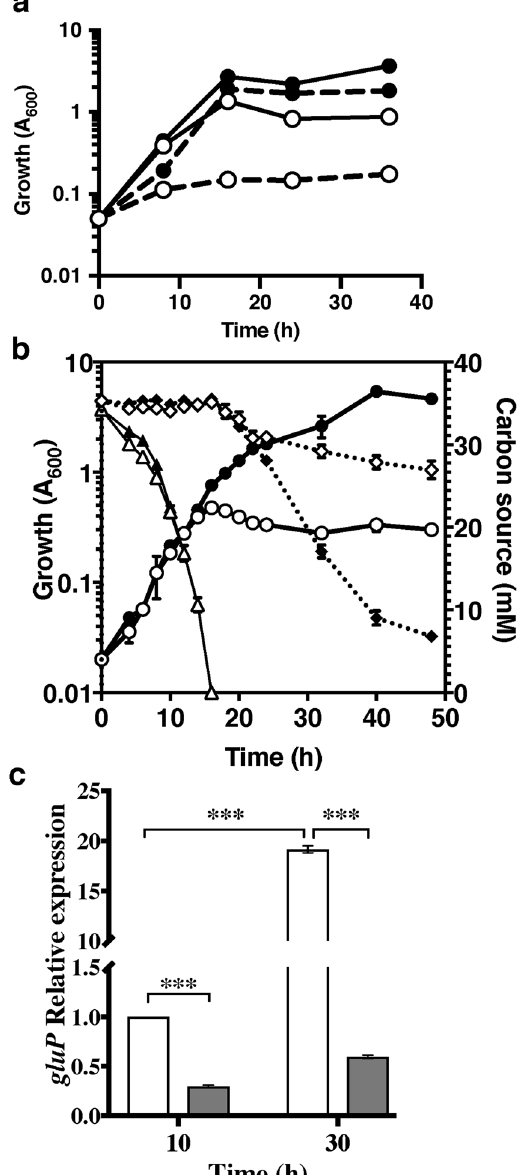
Figure 2. The HK CbrA is necessary for glucose utilization. ( a ) Growth kinetics of the reference strain AEalgD ( algD ::Km) (closed symbols) and its derivative mutant AH1 ( cbrA ::miniTn 5 ) (open symbols) in liquid Burk’s minimal medium amended with 50 mM glucose (dashed lines) or 2% sucrose (solid lines). ( b ) Growth kinetics (circles), and acetate (triangles) or glucose (diamonds) consumption during the culture of the reference strain AEalgD ( algD ::Km) (closed symbols) or its derivative mutant AH1 ( cbrA ::miniTn5) (open symbols) in Burk’s minimal medium supplemented with both 30 mM glucose and 30 mM acetate as carbon sources. ( c ) gluP mRNA levels determined by qRT-PCR analysis in strain AEalgD (white columns) and in mutant AH1 (grey columns) in the diauxic growth of panel ( b ). Total RNA was extracted from cells at the indicated times. The bars of standard deviation from three independent experiments are shown. Significant differences were analysed by t -test. Statistical significance is indicated ( *** p <